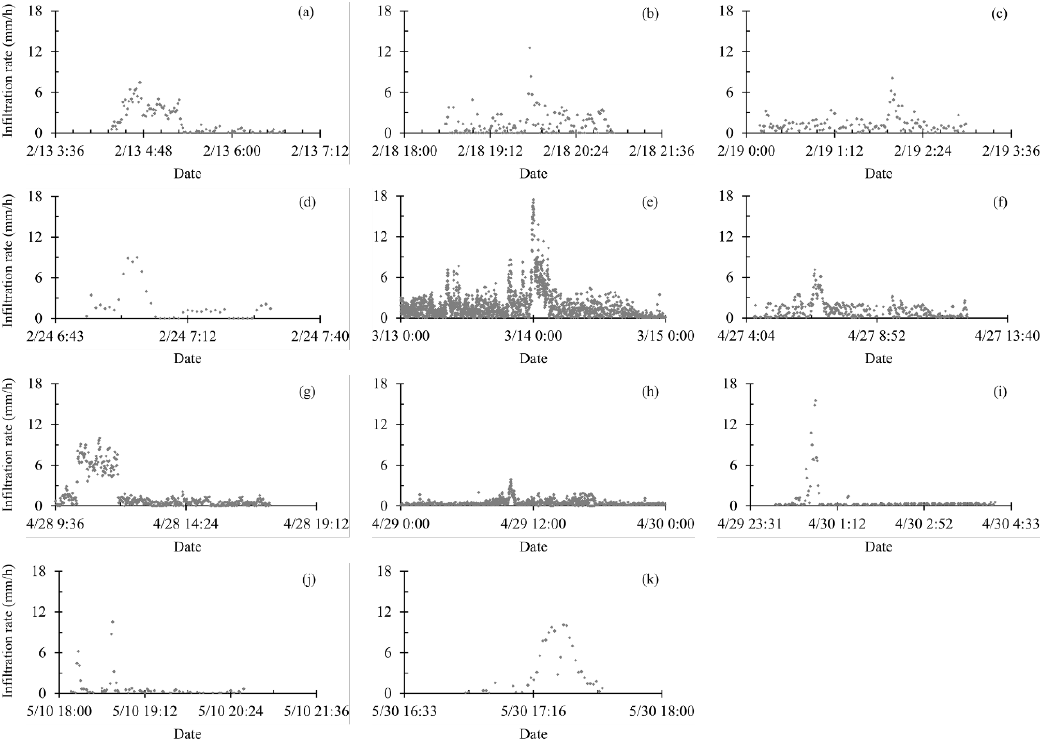
Figure 5. Soil water infiltration rate scatter diagrams, ( a ) 13 February; ( b ) 18 February; ( c ) 19 February; ( d ) 24 February; ( e ) 13 – 14 March; ( f ) 27 April; ( g ) 28 April; ( h ) 29 April; ( i ) 30 April; ( j ) 10 May; ( k ) 30 May.